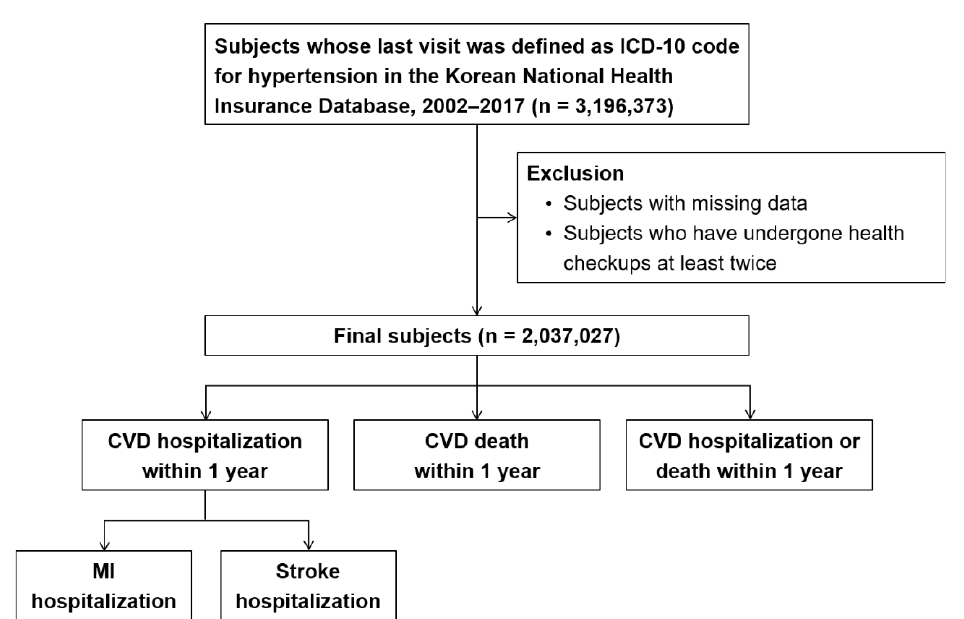
Figure 1. Flowchart showing the selection of study population. CVD: cardiovascular disease. ICD: international classification of diseases. MI: myocardial infarction.